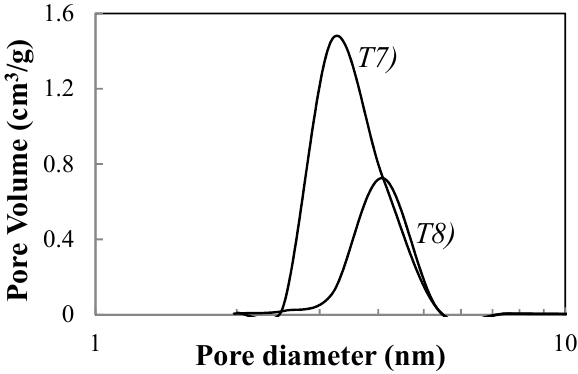
Figure 8. Pore size distribution of samples T7 and T8 determined according to BJH formula in desorption brunch of N 2 .